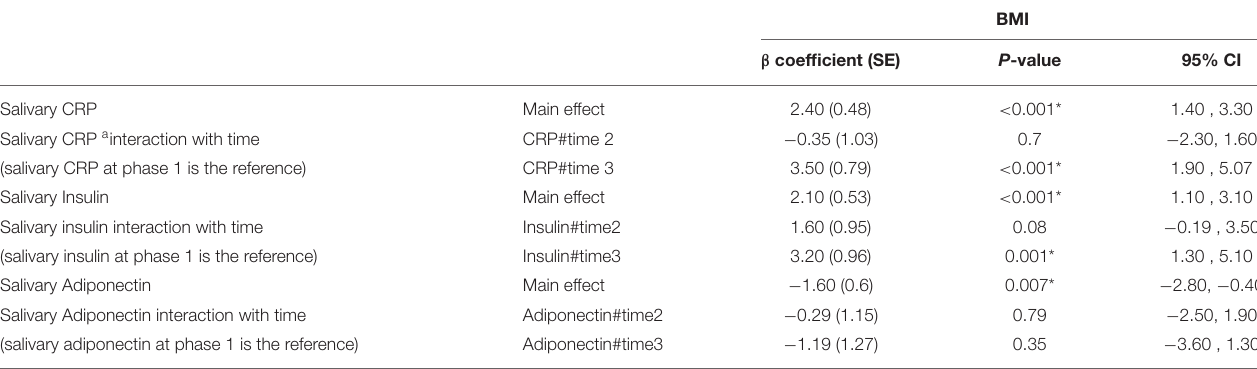
TABLE 6 | Multiple linear mixed models with random intercept and slope for the associations between BMI changes and the changes in the biomarker levels over time, adjusted for age and sex.